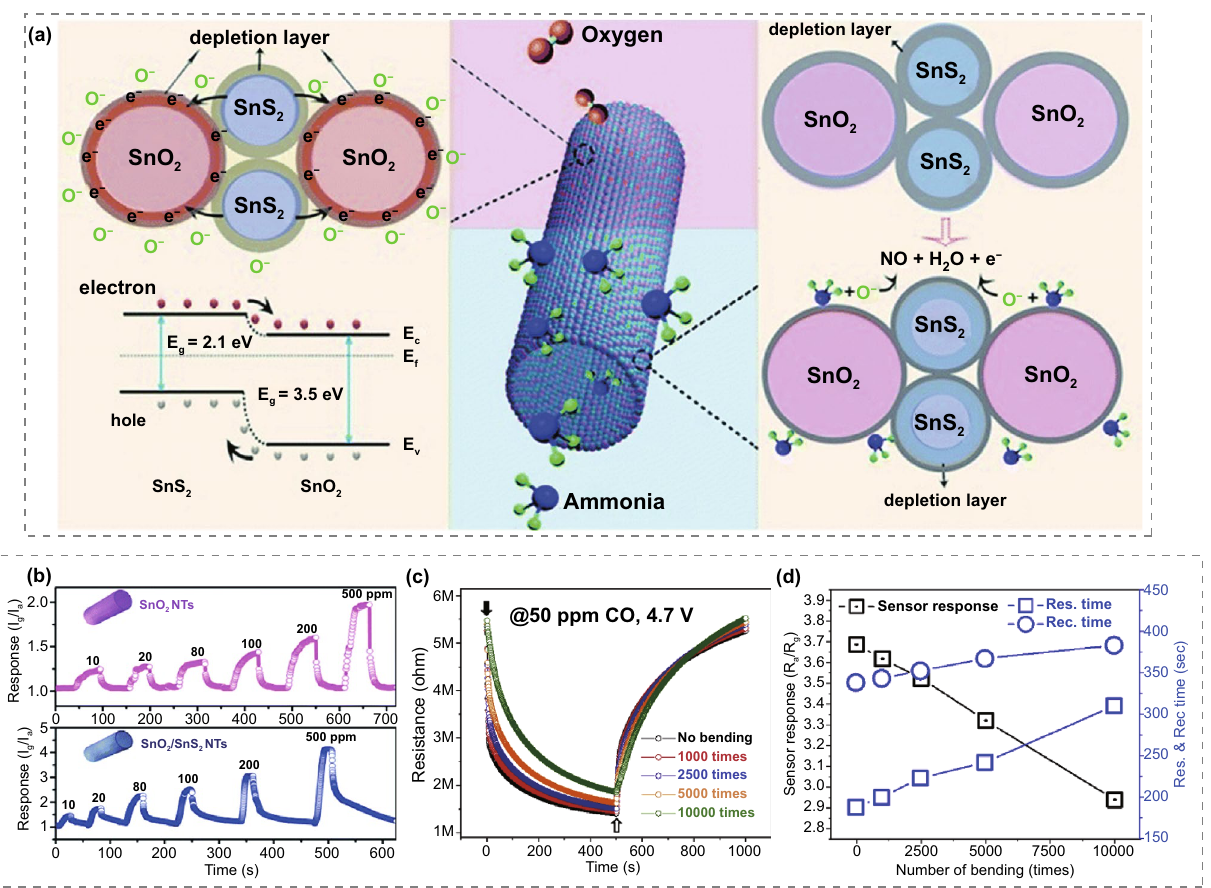
Fig. 9 a The sensing mechanism diagram of SnO 2 /SnS 2 nanotube in air and NH 3 atmosphere. b Transient response of the pristine SnO 2 and SnO 2 /SnS 2 to 10–500 ppm NH 3 at RT. Reproduced with permission from Ref. [88]. Copyright (2017) The Royal Society of Chemistry. c Dynamic resistance of Au/SnO 2 /WS 2 to 50 ppm CO after different cycles of bending tests. d Response values and response/recovery time of Au/ SnO 2 /WS 2 to 50 ppm CO after different cycles of bending tests. Reproduced with permission from Ref. [221]. Copyright (2021)